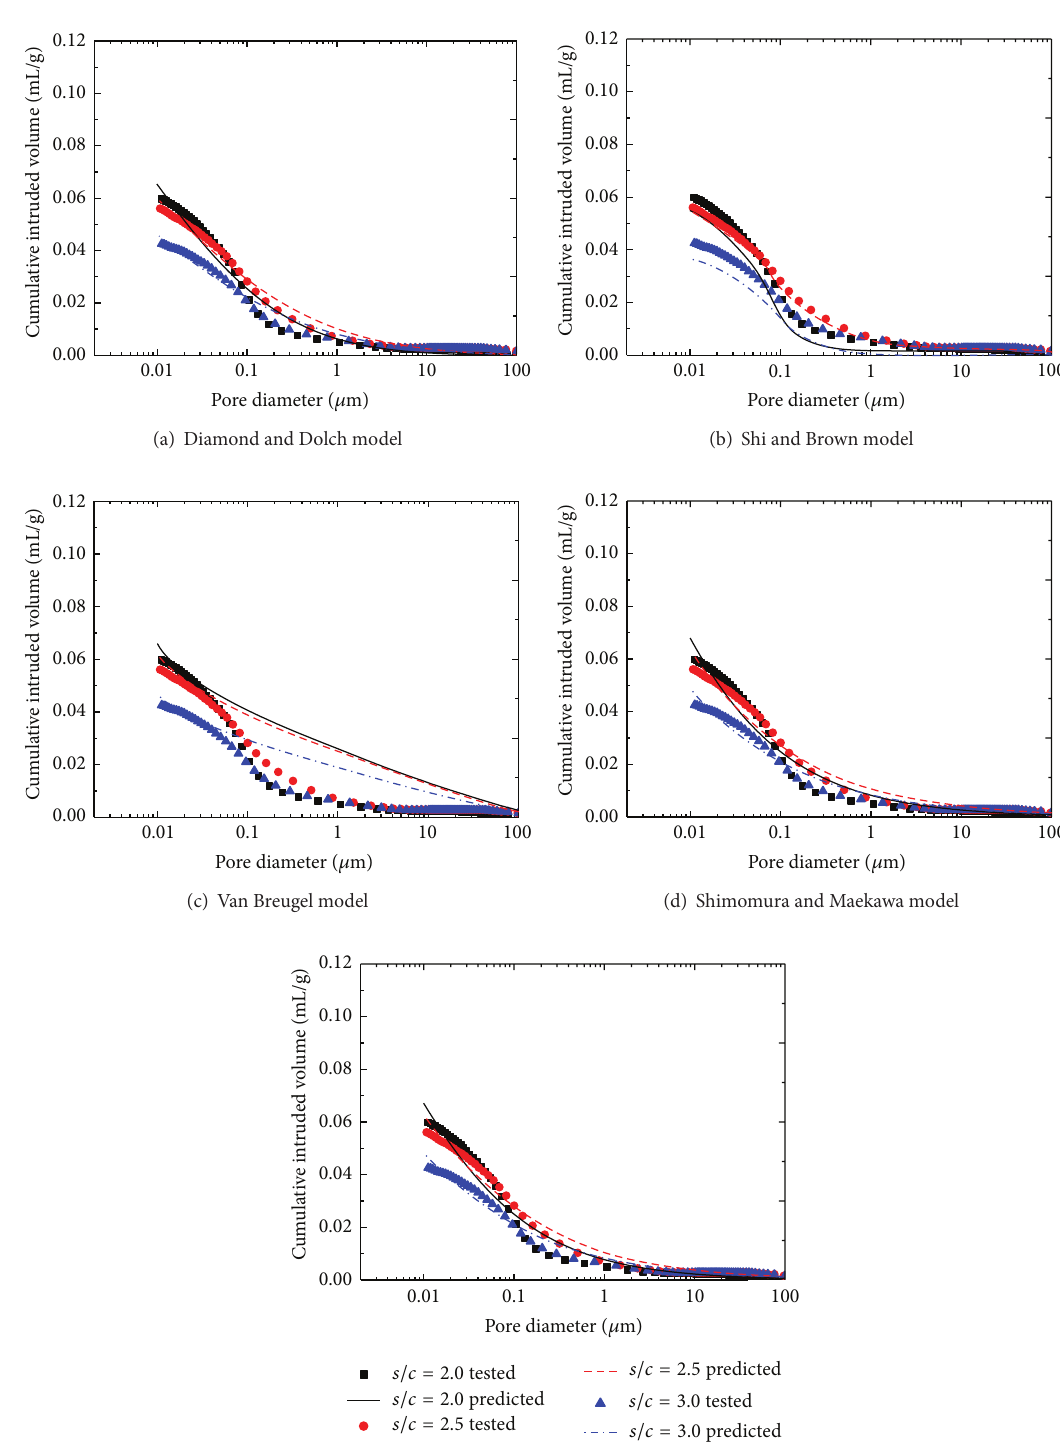
Figure 7: Comparison between test and predicted results by existing models for natural sand